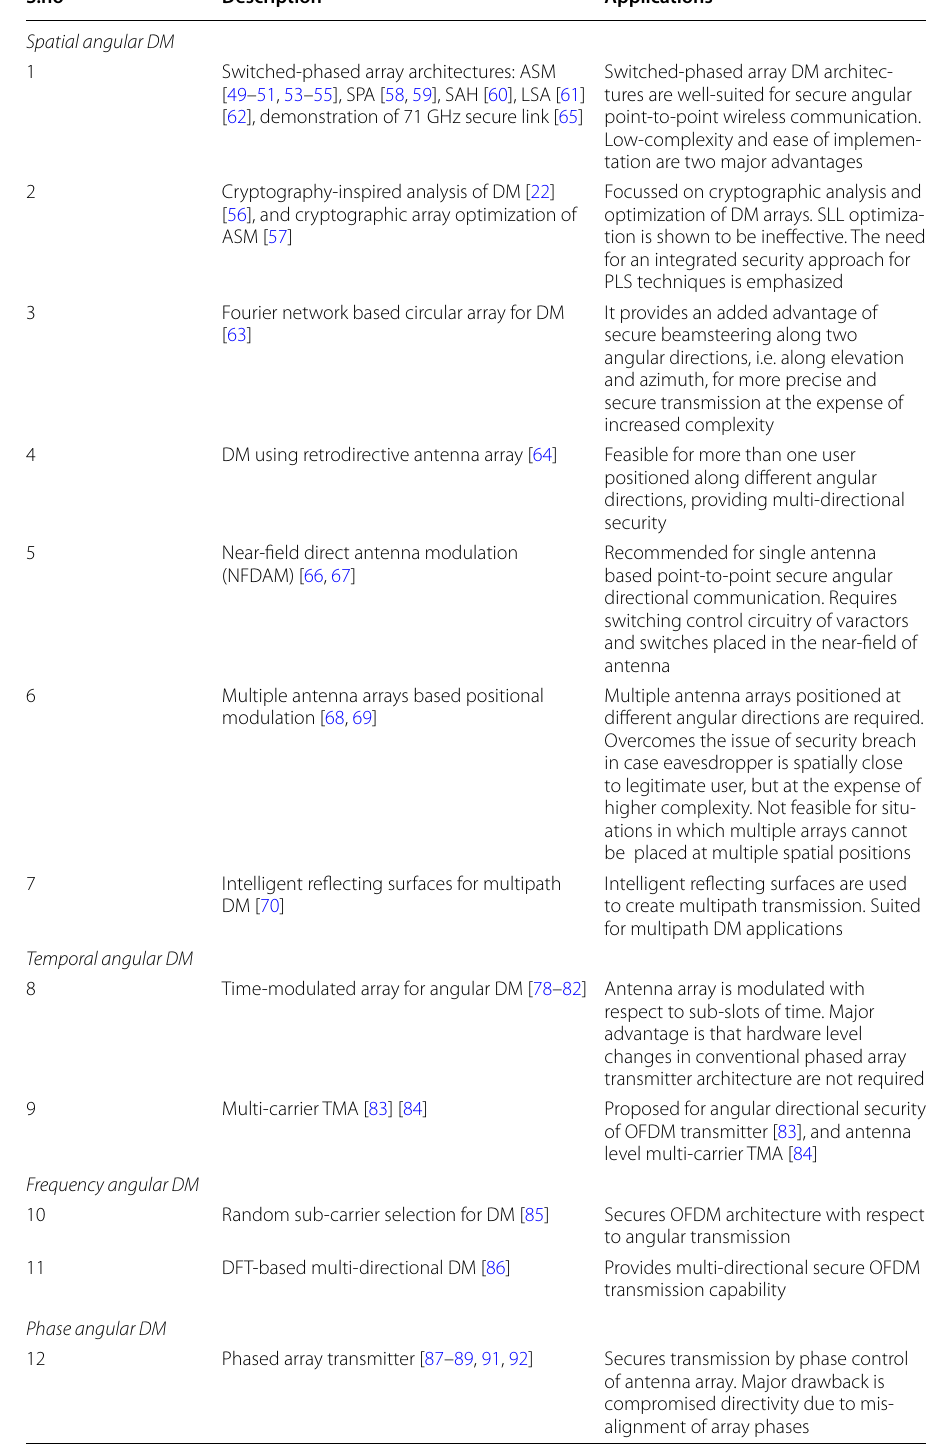
Table 4 Application specific comparison of angular DM techniques